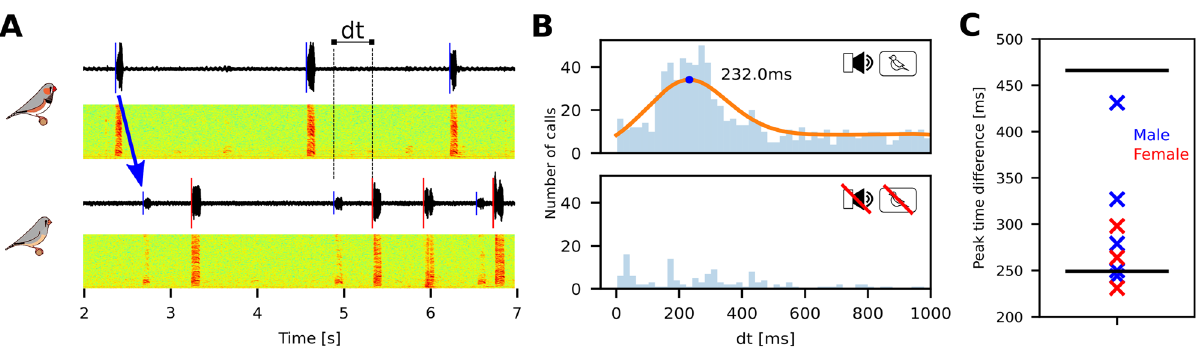
Figure 2. Zebra finches communicating through the setup exhibit established call timing behaviour. ( A ) Sound oscillograms and spectrograms for the stack calls of a male and a female communicating through two setups. Detected onsets are indicated by vertical lines on the oscillograms. The arrow denotes that the playback of the male call can be seen in the recording of the female. We measure the time dt from playback to answer. ( B ) Histogram of the elapsed time between the playback of the mate’s call until next call in one pair. The peak of the kernel density estimate is marked. Bottom plot shows a histogram of time differences for the same pair with the system off. ( C ) Summary showing the peak for all 8 birds. The black lines show the range of values reported in 10 distributed (Fig. 2B) with a peak delay at 291 ms (median: 271 ms, range: 231–431 ms, N = 8, Fig. 2B,C). This data is consistent with previous published ranges of call timing delay (249–466 ms 10 and 68–283 ms 27 ). Because